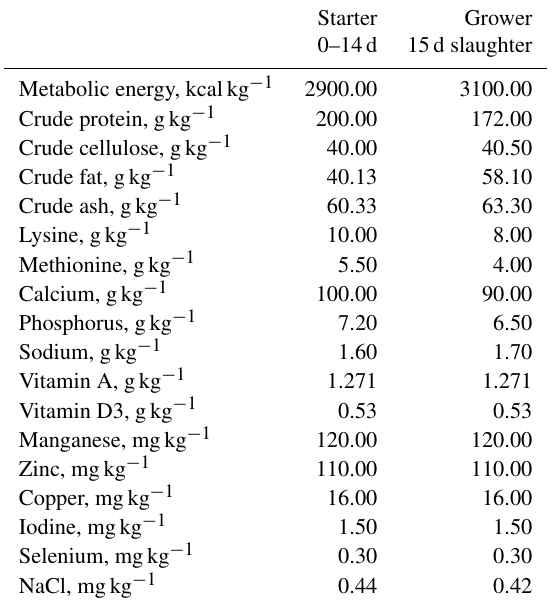
Table 1. The nutritive and chemical values of the feed used in the